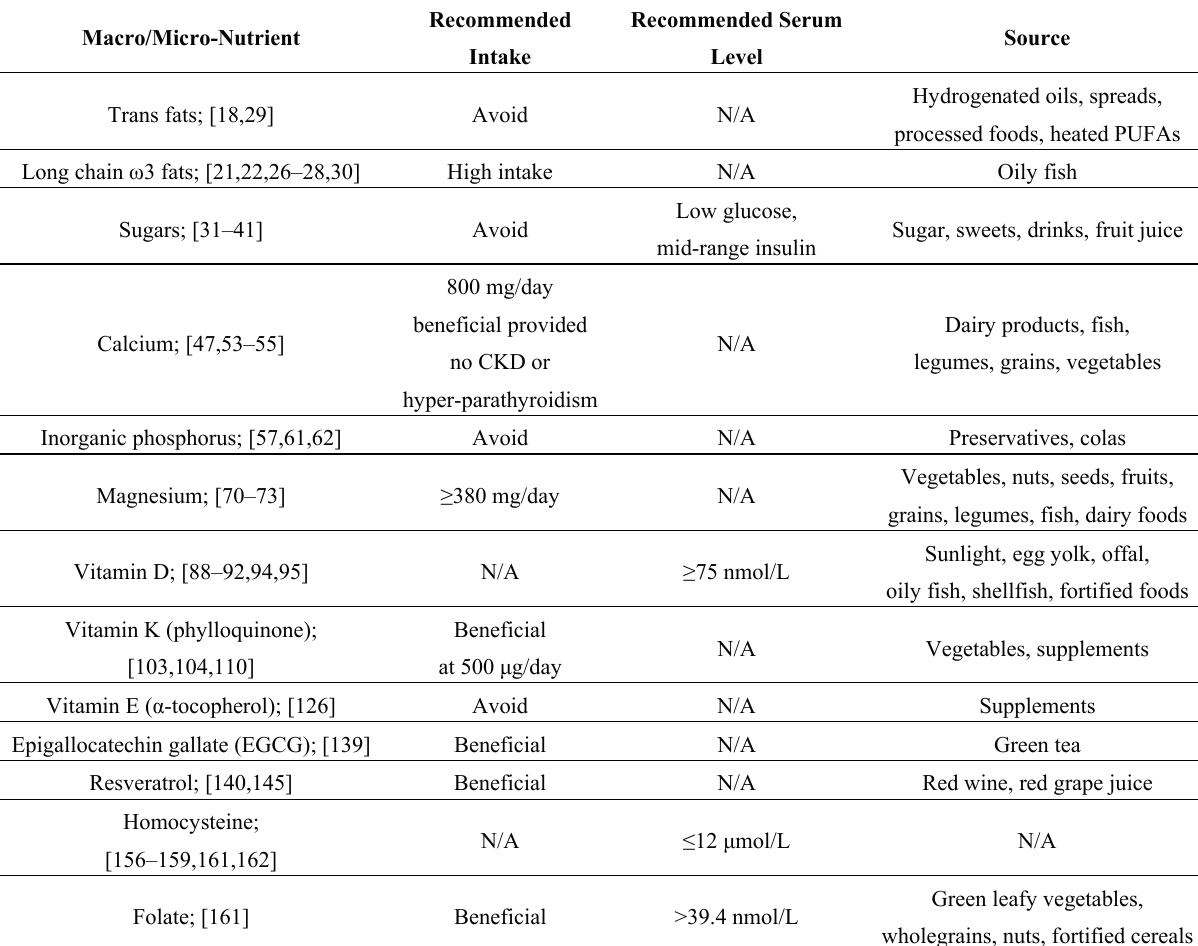
Table 1. Dietary and serum recommendations from human studies of cardiovascular